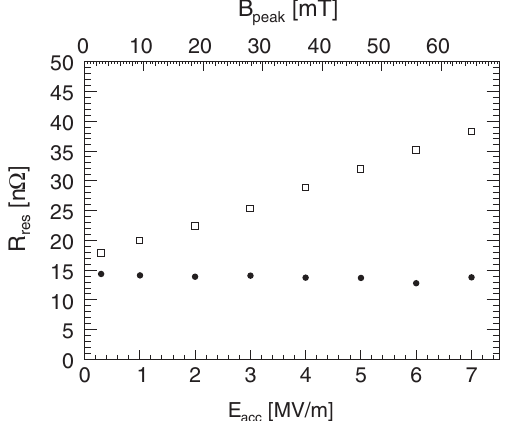
FIG. 4. Residual resistance due to the external field as a function of the accelerating field. The circles show the re- duced-field ( 5 μ T) cooling result, and blank squares show the data when the ambient field was about 100 μ T.